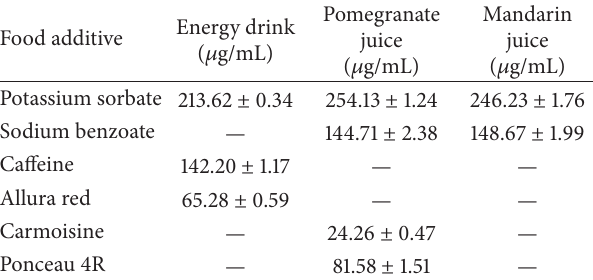
Table 7: Analysis of soft drinks (mean value ± standard deviation, 𝑛 = 5